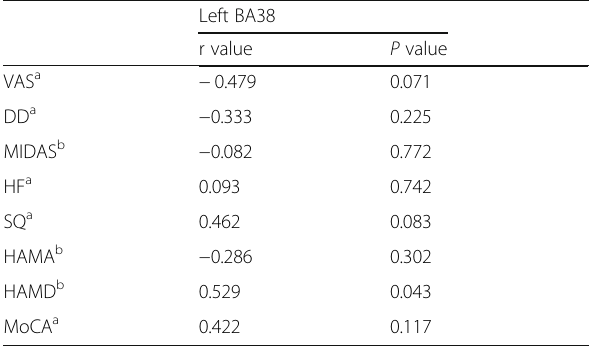
Table 1 Correlation analysis between the CBF value of the brain region with hyperperfusion and the clinical variables Left BA38